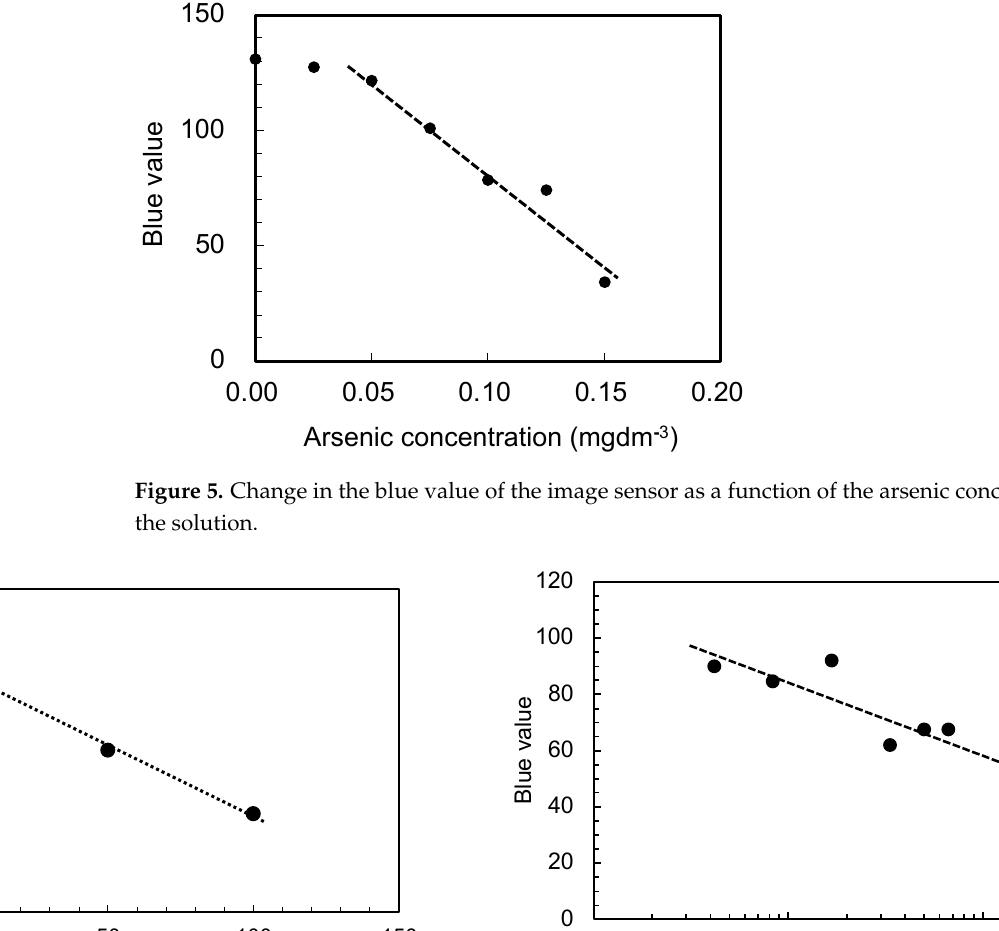
Figure 5. Change in the blue value of the image sensor as a function of the arsenic concentration in the solution.